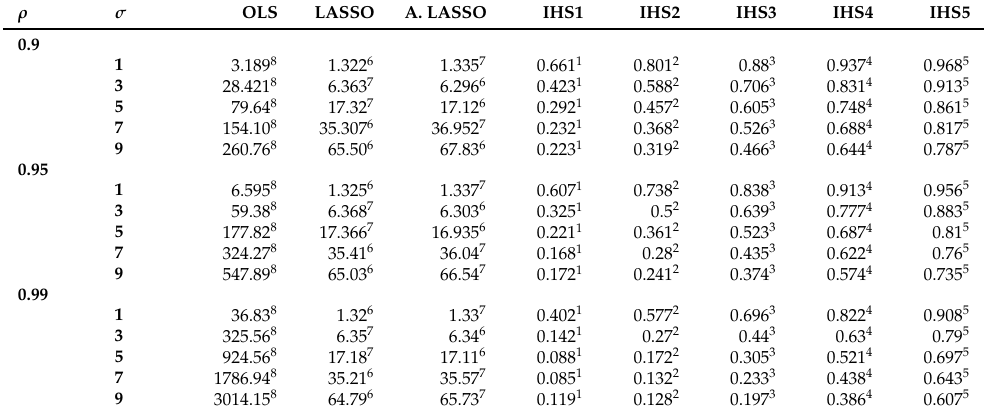
Table 7. Estimated MSEs for n = 50 and p = 16 (superscript represents ranking).